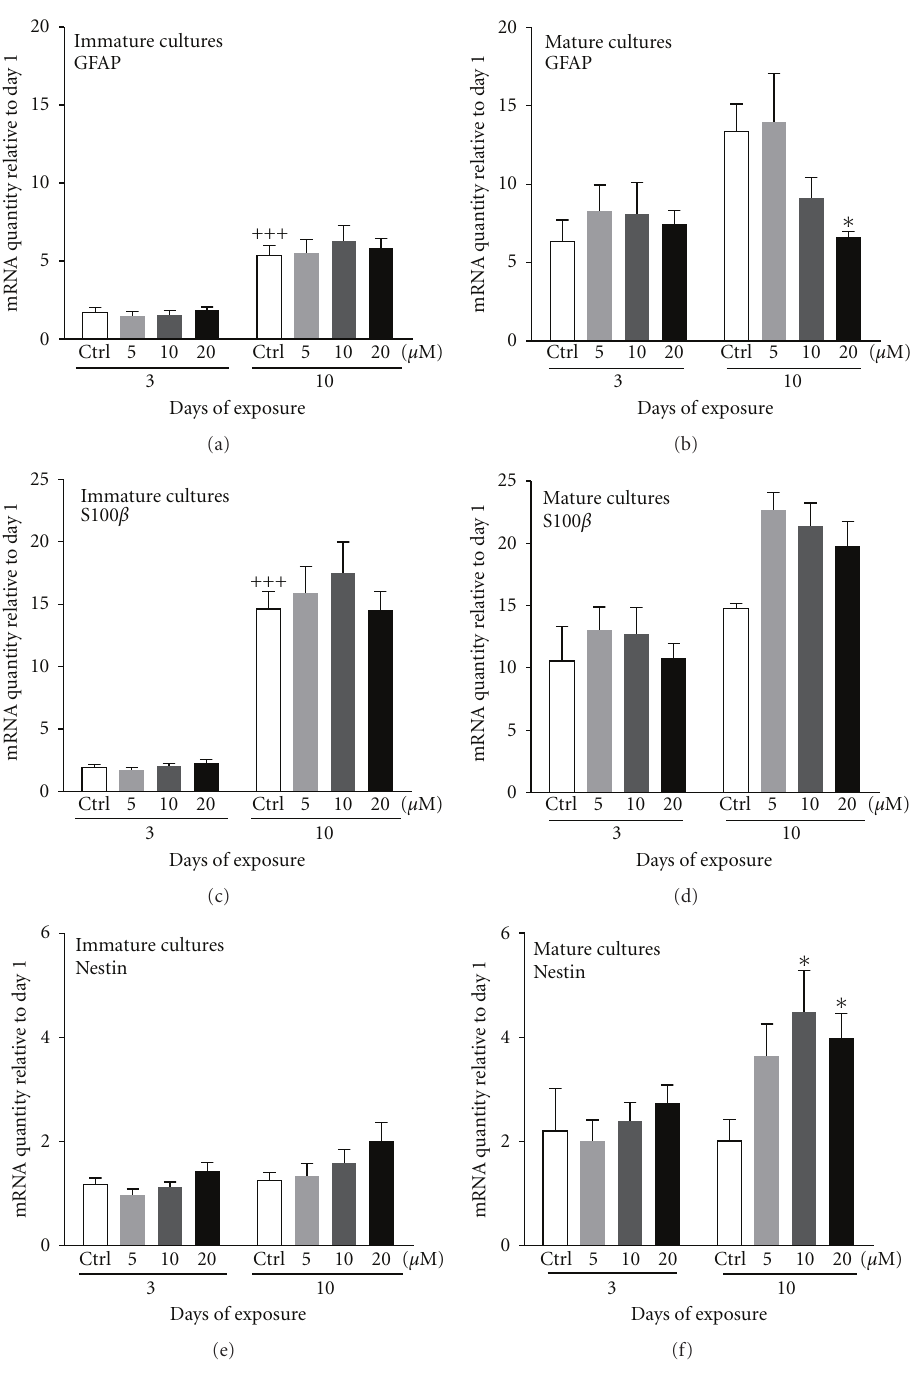
Figure 3: Changes in the mRNA levels of astrocytic and neural precursor markers in primary cultures of CGCs exposed to domoic acid (5 μ M, 10 μ M, and 20 μ M) at 1 DIV (immature cultures) or at 7 DIV (mature cultures) for 3 or 10 days. There were no observed changes for (a) GFAP in immature cultures, (c) S100 β in immature cultures, and (e) nestin expression in immature cultures. However, there was a significant decrease of (b) GFAP mRNA levels in mature cultures after 10 days of exposure (20 μ M) and increase of (d) S100 β mRNA expression in mature cultures after 10 days of exposure and (f) nestin mRNA expression in mature cultures after 10 days of exposure. Gene expression levels were normalized to the standard calibrator, the housekeeping gene 18S rRNA and the mRNA expression at 1 DIV. Data represent mean ± S.E.M. of three independent experiments performed in duplicates. + P < 0 . 05 ++ P < 0 . 01 +++ P < 0 . 001 comparing control cultures at 3 and 10 days. ∗ P < 0 . 05 ∗∗ P < 0 . 01 ∗∗∗ P < 0 . 001 comparing treated to control (untreated)